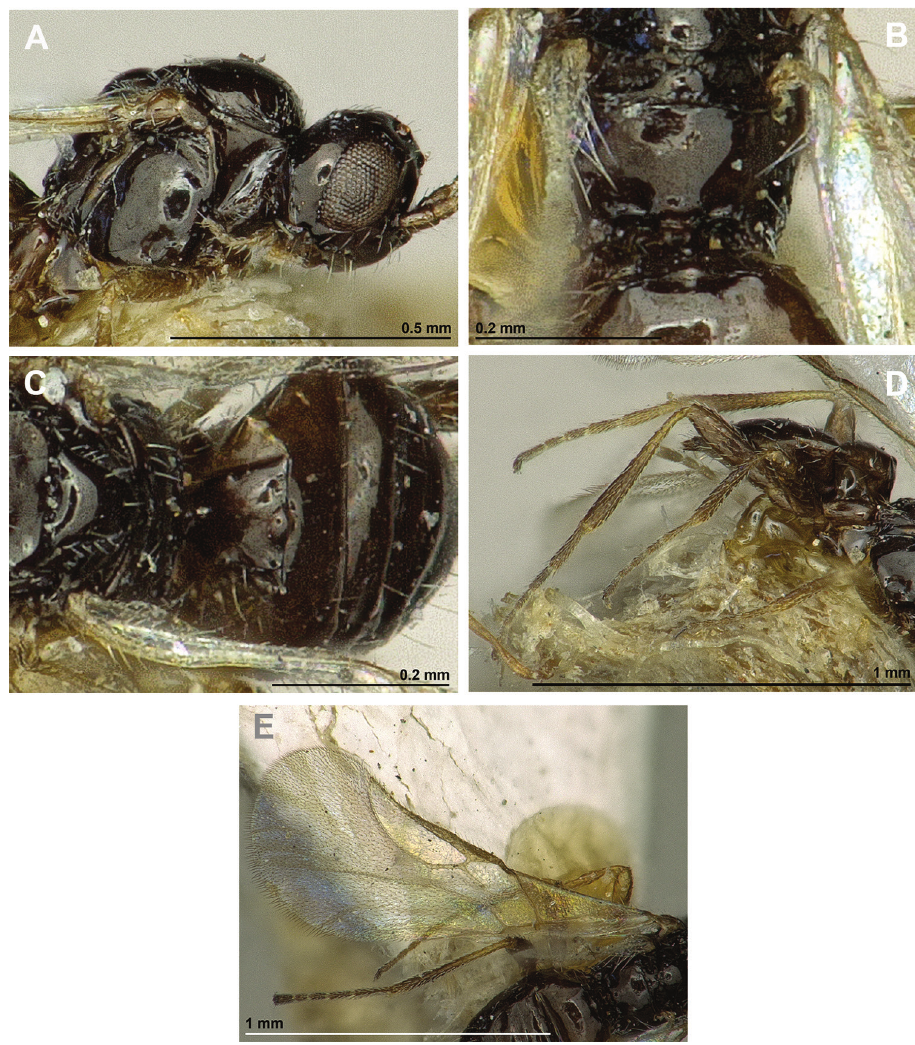
Figure 6. Hoplocrotaphus mysteriosus Fischer, 1971 (female, holotype) A Head and mesosoma, lateral view B Propodeum, dorsal view C First metasomal tergite D Legs, metasoma and ovipositor, lateral view E Fore